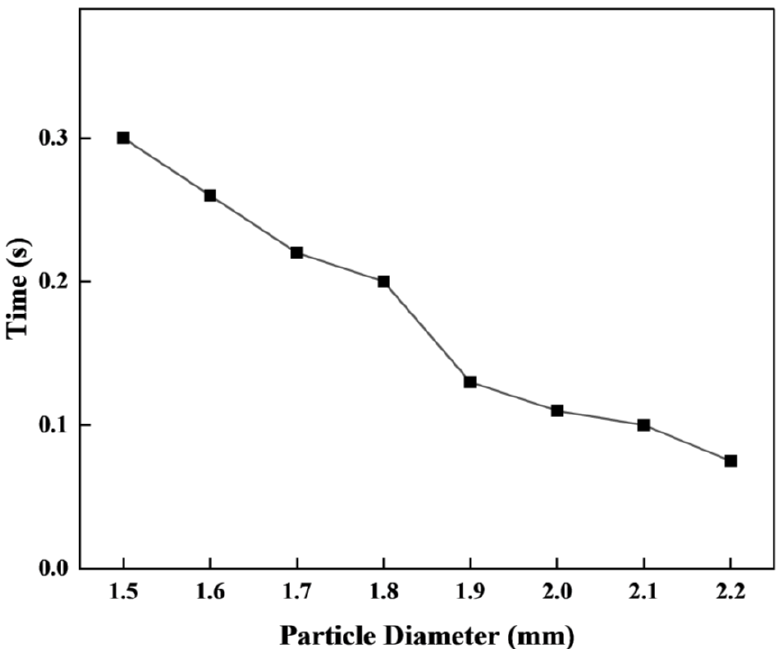
Figure 12. Effect of particle size of LCMs on the plugging time under the condition of mass flow of 3 kg/s.